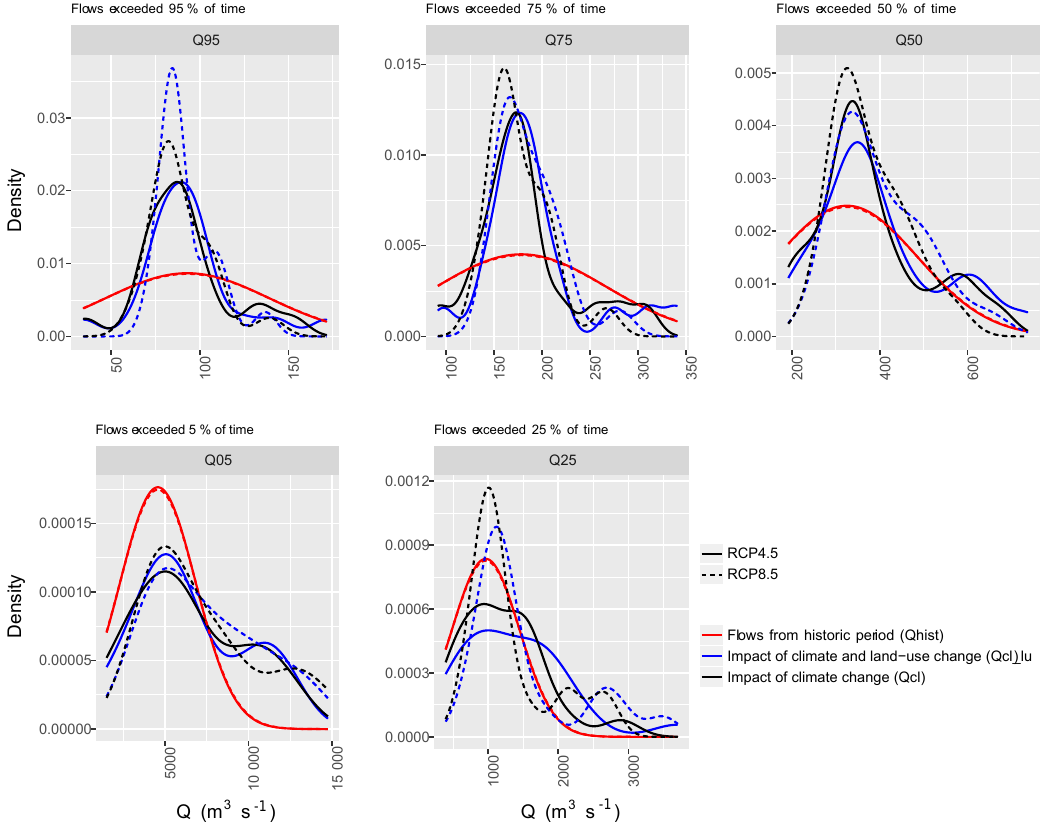
Figure B2. Kernel density plots showing distribution of Q 5 , Q 25 , Q 50 , Q 75 and Q 95 (i.e. flows exceeded 5, 25, 50, 75 and 95% of time respectively) among different GCMs, for the Upper Ganges basin, under both emission scenarios. Black: only climate change is taken into account (Q cl ) ; simulation period 2030–2035. Blue: both climate change and land-use change are taken into account (Q cl_lu ) ; simulation period 2030–2035. Red: historical period (Q hist ) ; simulation period 2000–2005.